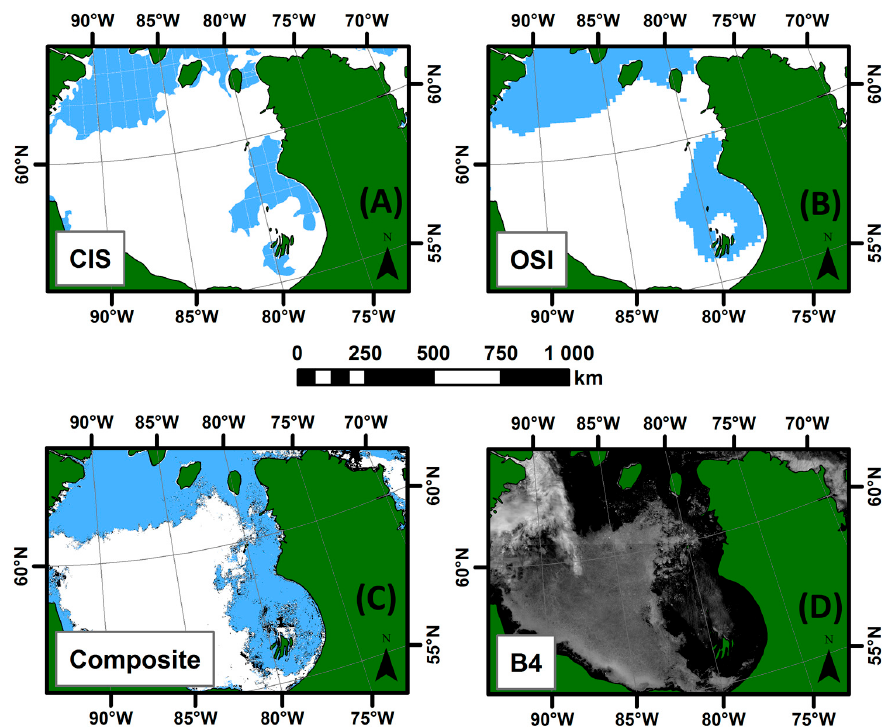
Figure 10. Comparison of ice extent as depicted by the CIS weekly map ( A ), the OSI 7 day average ( B ), the IceMap250 composite map ( C ), and the green band of MODIS ( D ) for 27 June 2016. Sea ice is presented in white and water in blue. Black pixels in the composite map denote missing data.